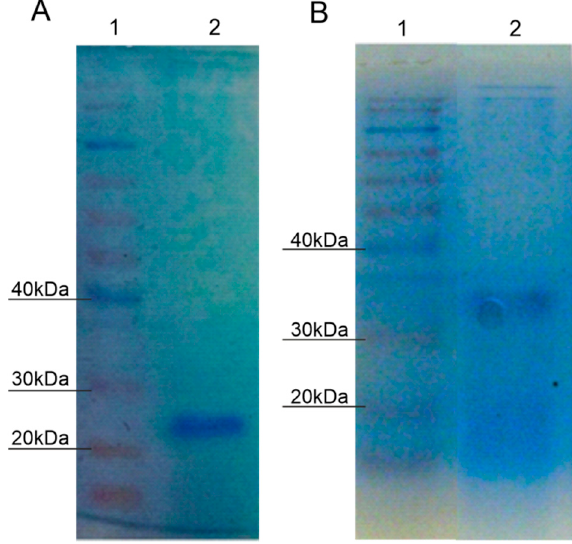
Figure 2. SDS-PAGE of partially purified (enriched fractions) enzymes from P. putida F6. ( A ) lane 1— protein standard, lane 2—Lacc1 fraction (~24 kDa); ( B ) lane 1—protein standard, lane 2—Lacc2 fraction.